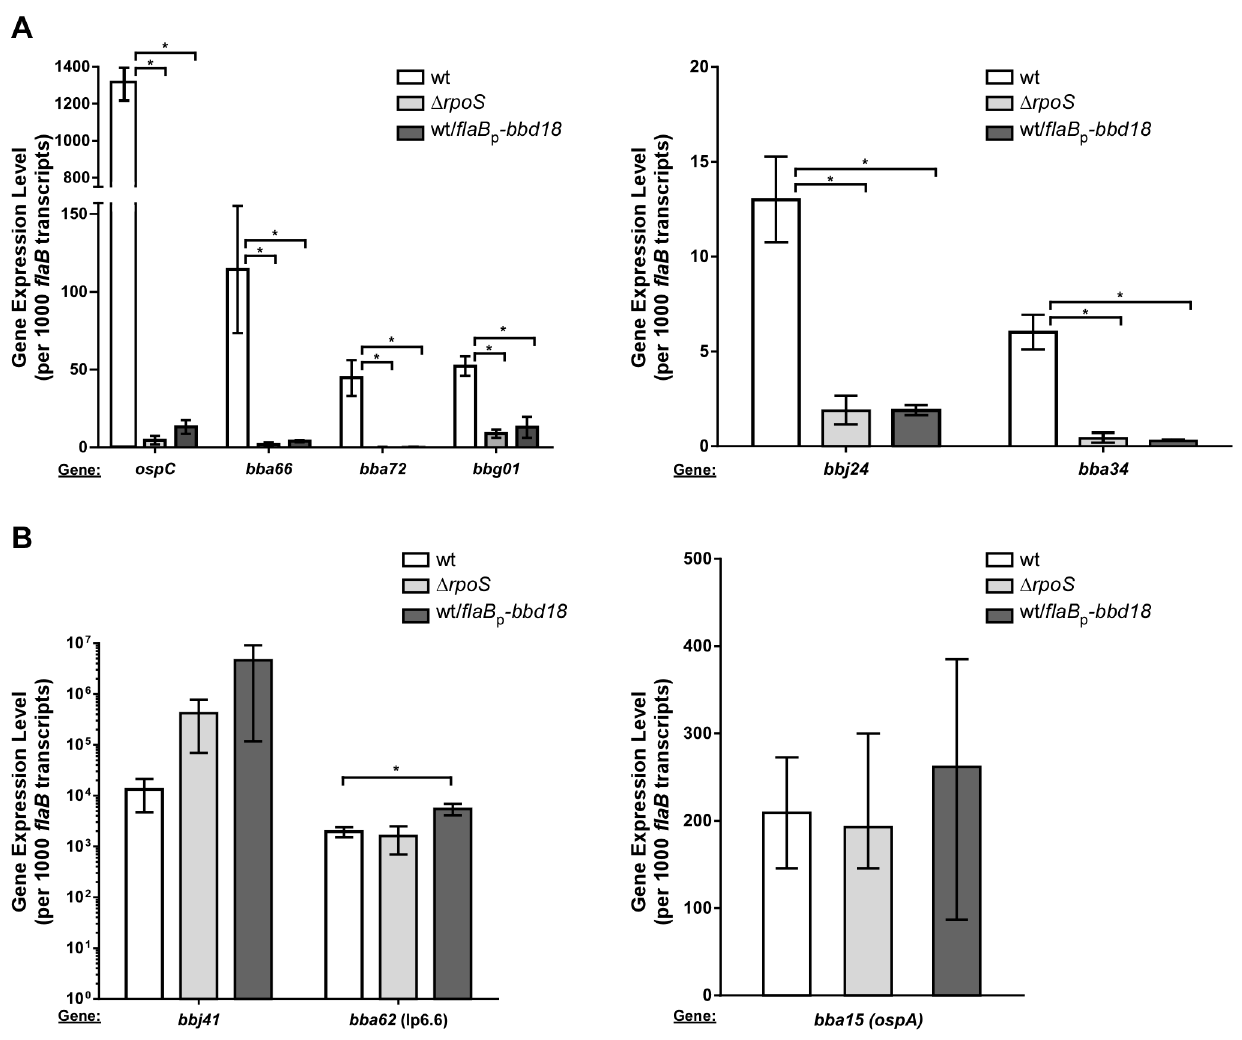
Figure 2. Analysis of RpoS-dependent and RpoS-independent gene transcription. Quantitative reverse transcriptase-PCR (qRT-PCR) analysis of gene expression in strains B31-S9 (wt), B31-S9 D rpoS ( D rpoS ) and B31-S9/pBSV2*- flaB p- bbd18 (wt/ flaB p- bbd18 ), grown under rpoS- inducing conditions (BSKII medium, pH6.8). The transcript level of RpoS-dependent genes ospC , bba66 , bba72 , bbg01 , bbj24 , and bba34 (A) and RpoS- independent genes bbj41 , bba62 ( lp6 .6) and bba15 ( ospA ), (B) are shown as relative units, and normalized to the constitutively expressed flaB transcript. Data were analyzed using Student’s unpaired t-test and brackets marked with asterisks represent a statistically significant difference (p ,